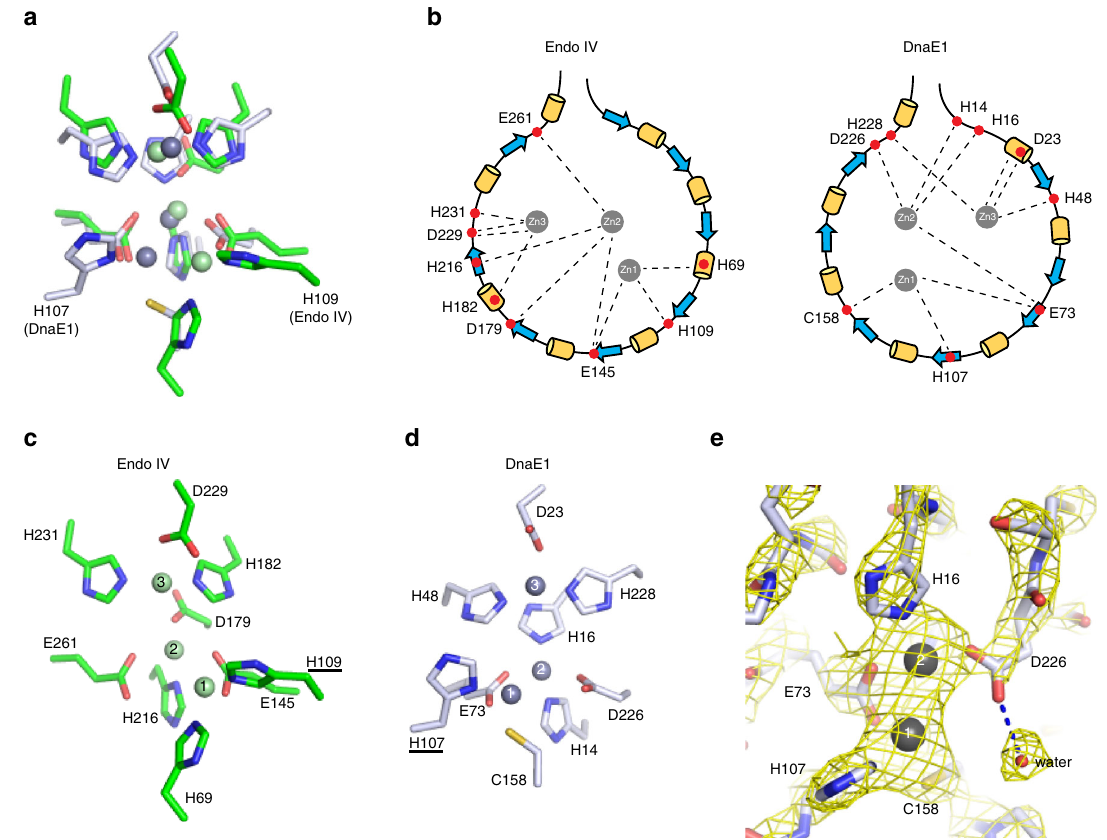
Fig. 5 The PHP-exonuclease active site is analogous to endonuclease IV. a Overlay of the catalytic residues of DnaE1 (in gray ) and E. coli Endo IV (in green ). Note the mirrored position of Endo IV H109 and DnaE1 H107. b Schematic view of the positions of the residues that coordinate the zinc ions in Endo IV ( left ) and DnaE1 ( right ). The zinc-coordinating residues originate from entirely different locations, indicating the two enzymes do not have a common evolutionary origin. c Histidine 109 that ligands Zn 1 in Endo IV is positioned to the ‘ right ’ of the active site and pulls Zn 1 away from the center line. d In DnaE1, the analogous histidine (His 107) has moved to the other side of the active site, moving Zn 1 with it. e In DnaE1, glutamate 73 (E73) ligands both Zn 1 and Zn 2 , whereas aspartate 226 (D226) only ligands Zn 2 and makes a hydrogen bond with a water molecule. Electron density show at 2.3 σ in yellow